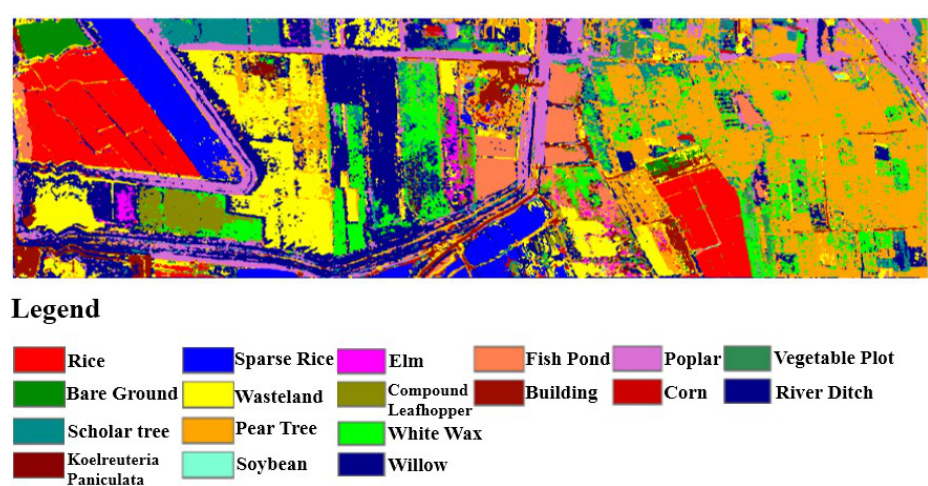
Figure 22. Land classification map.